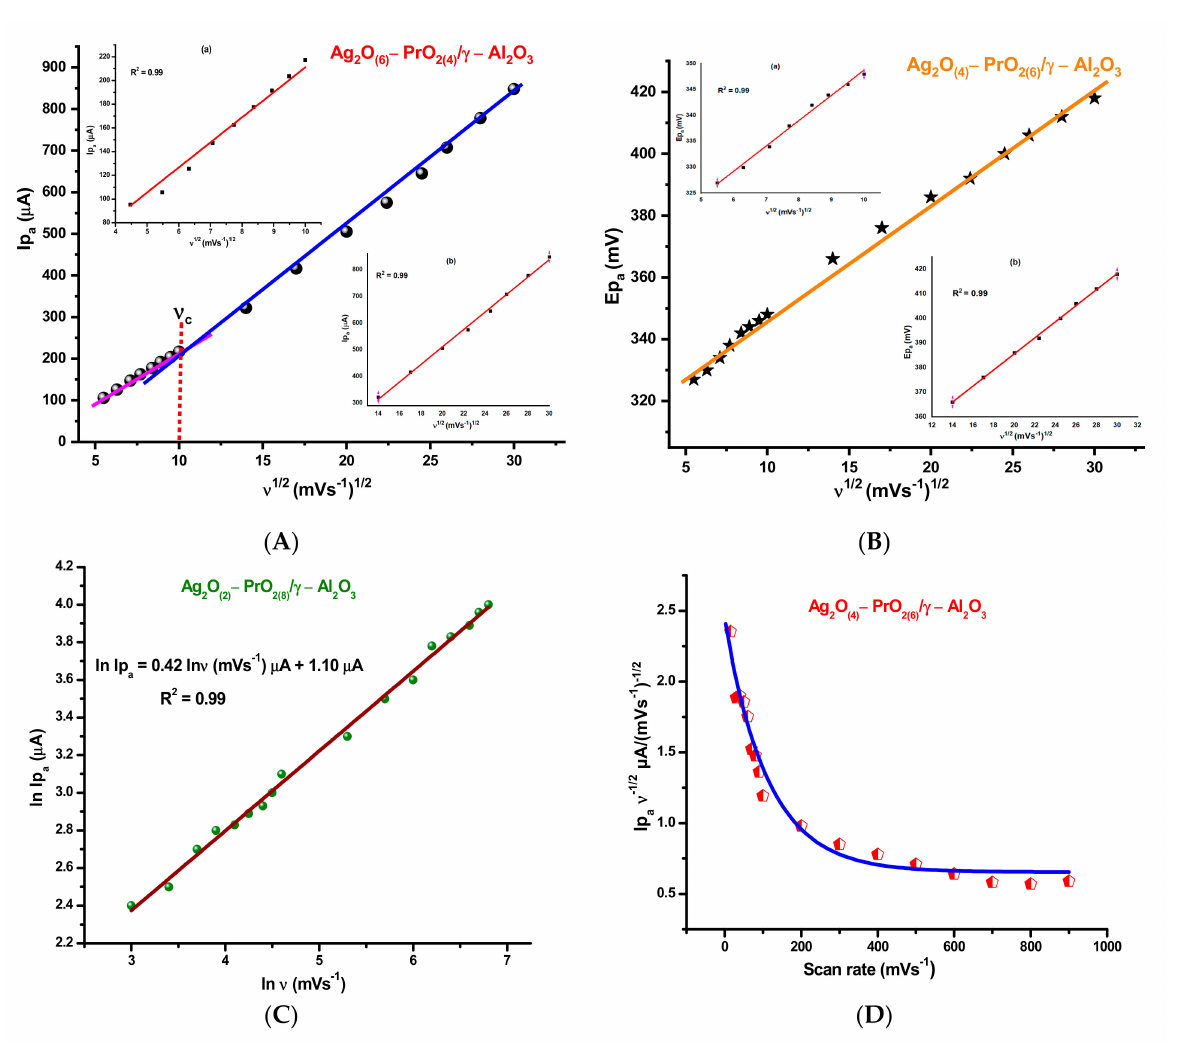
Figure 10. ( A ) Dependence of Ip a on ν 1/2 ; insets (a) and (b) show linear fitting for lower and higher scan rates for Ag 2 O (6) – PrO 2(4) / γ -Al 2 O 3 /GC. ( B ) Characteristic shift in peak potential with ν 1/2 for Ag 2 O (4) –PrO 2(6) / γ -Al 2 O 3 /GC, insets (a) and (b) show linear fitting for lower and higher scan rates. ( C ) Dependence of Ip a on potential scan rate in double logarithm coordinates for ammonia oxidation on Ag 2 O (2) –PrO 2(8) / γ -Al 2 O 3 /GC. ( D ) Variation of current function (Ip a ν − 1/2 ) with ν for Ag 2 O (4) –PrO 2(6) / γ -Al 2 O 3